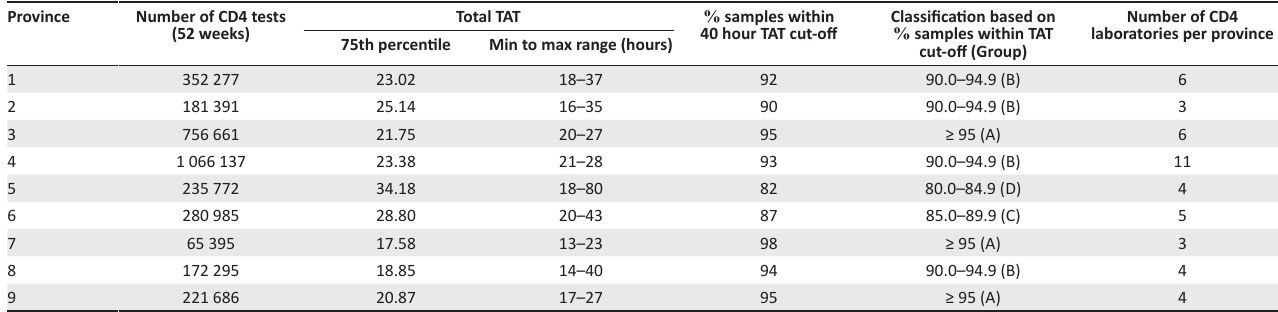
TABLE 2: Annual provincial National Health Laboratory Service CD4 data, indicating test volumes, the 75th percentile total turn-around time, the percentage of samples within turn-around time cut-off and the number of representative laboratories for 2016/2017 financial year. Province Number of CD4 tests Total (52 weeks)